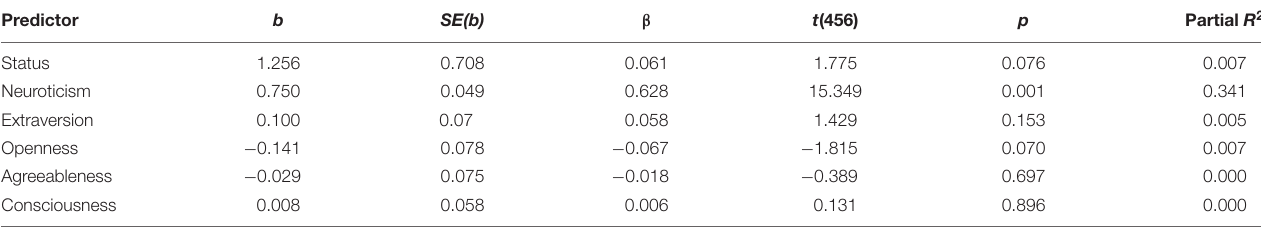
TABLE 5 | Results of the regression analysis predicting avoidance coping.